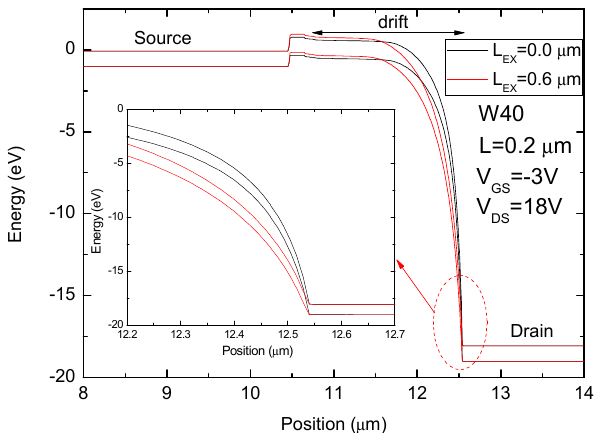
Figure 6. Longitudinal energy band diagrams of W40 with L EX = 0 and L EX = 0.6 μ m at V GS = − 3 V and V DS = 18 V.